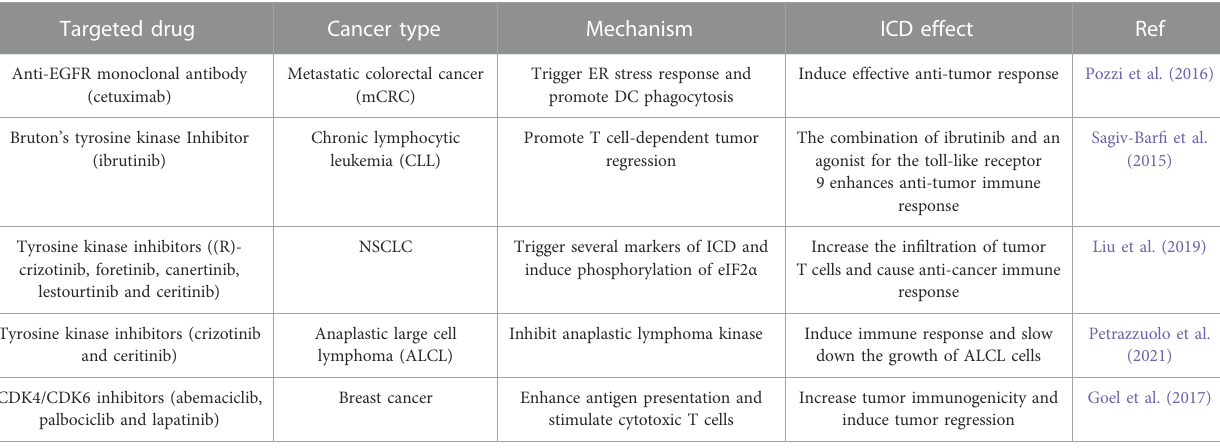
TABLE 3 The targeted drugs-induced